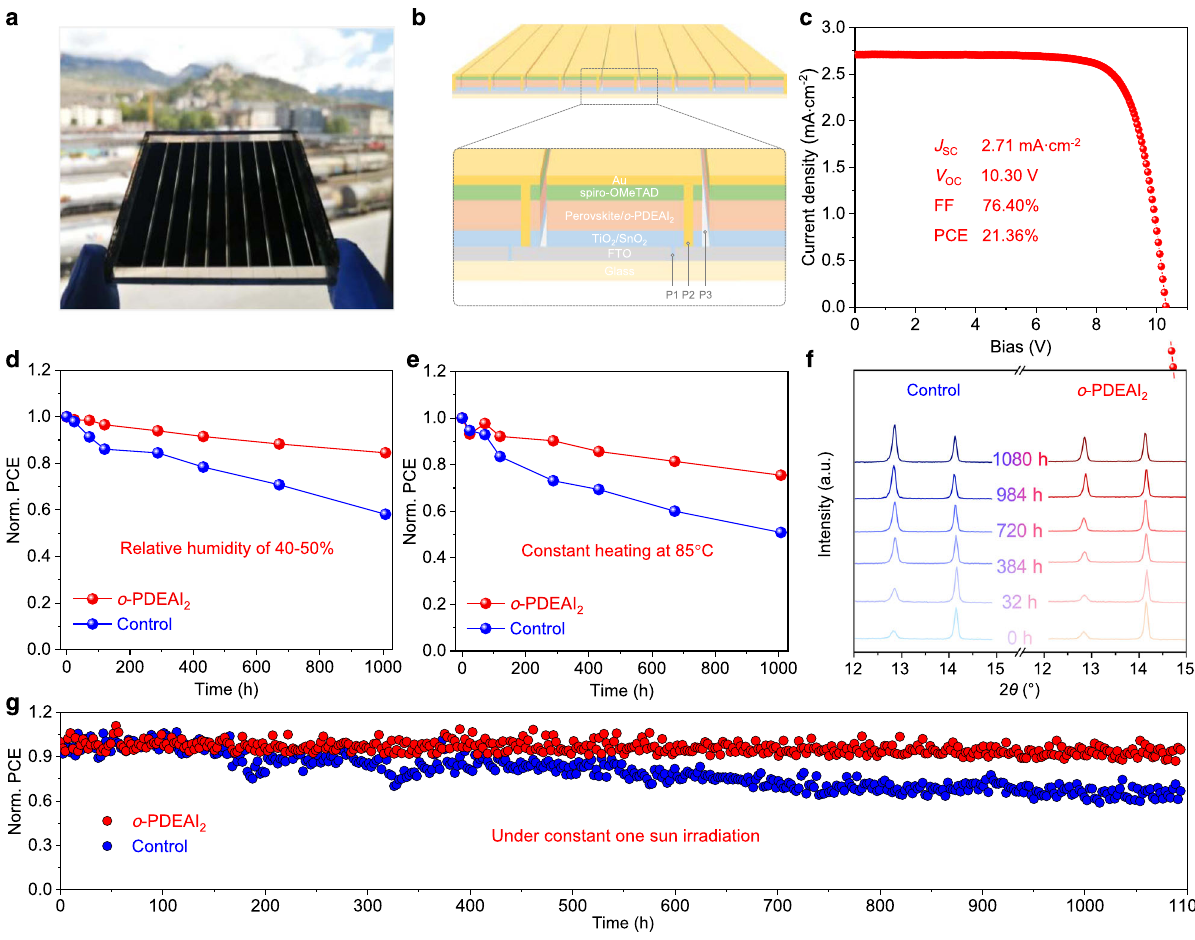
Fig. 5 Module performance and long-term stability of the PSCs. a Photograph of the fabricated perovskite solar module. b Schematic showing the interconnections of the module. c J – V characteristics of the champion perovskite solar module with an active area of 26.00 cm 2 . d Evolution of the PCEs for the unencapsulated devices exposed to a controlled relative humidity (RH) of 40 – 50% in the dark. e Evolution of the PCEs for the unencapsulated devices under constant heating at 85 °C in a nitrogen atmosphere. f XRD patterns of the perovskite fi lms as a function of annealing time at constant 85 °C. g Maximum power point tracking (MPPT) for 1100 h of the unencapsulated devices under continuous light (100 mW cm − 2 ) illumination at 25 °C in a nitrogen